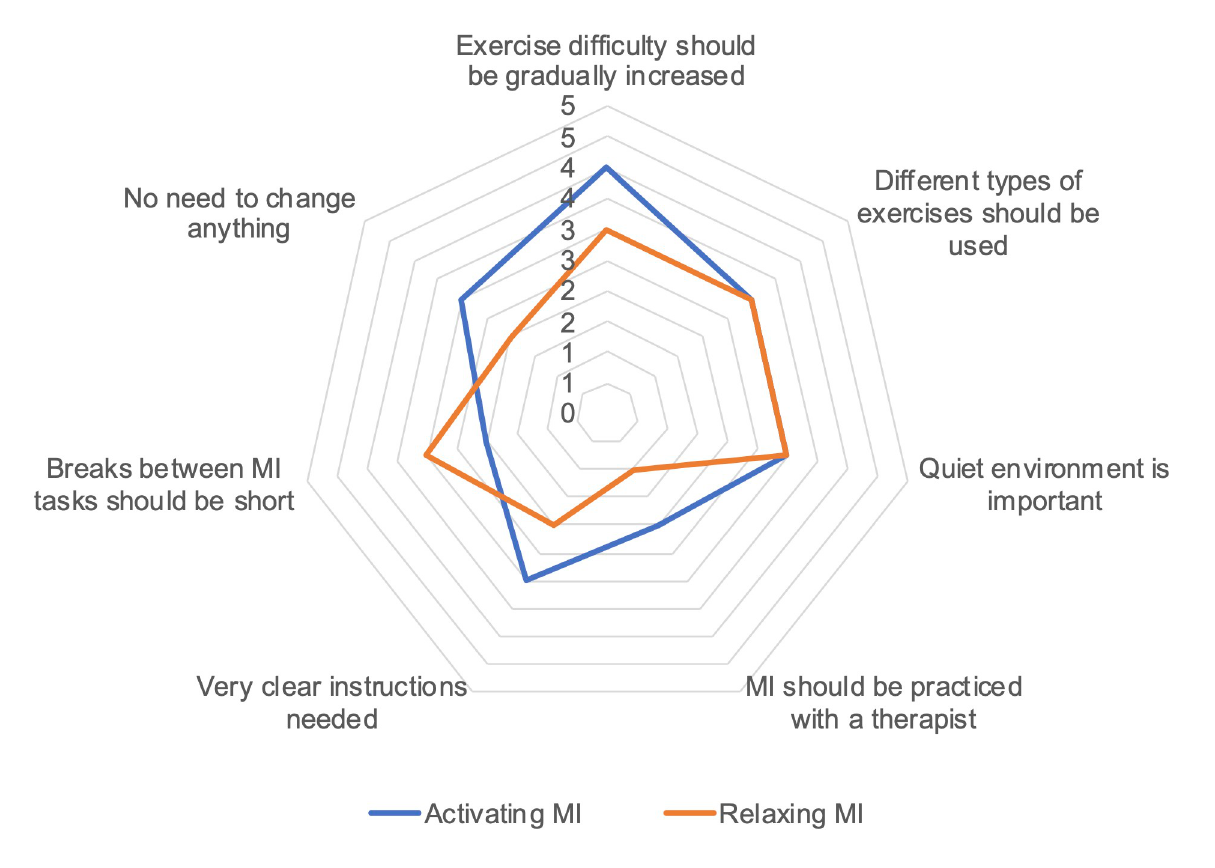
Fig 6. Motor imagery recommendations from study participants. Numbers on the radar graph represent the numbers of participants in the two intervention groups who expressed the respective opinions.